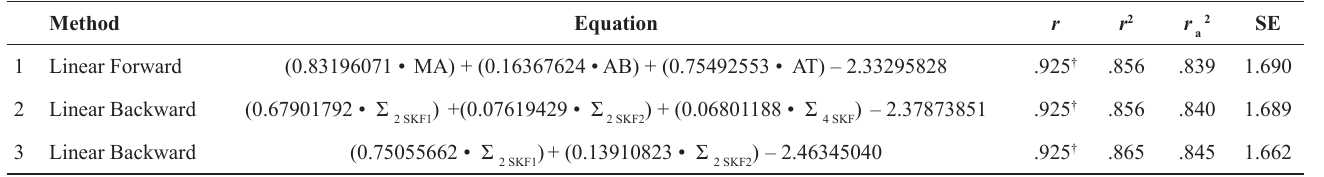
Table 3. Novel equations proposed to predict body fat in professional soccer players.